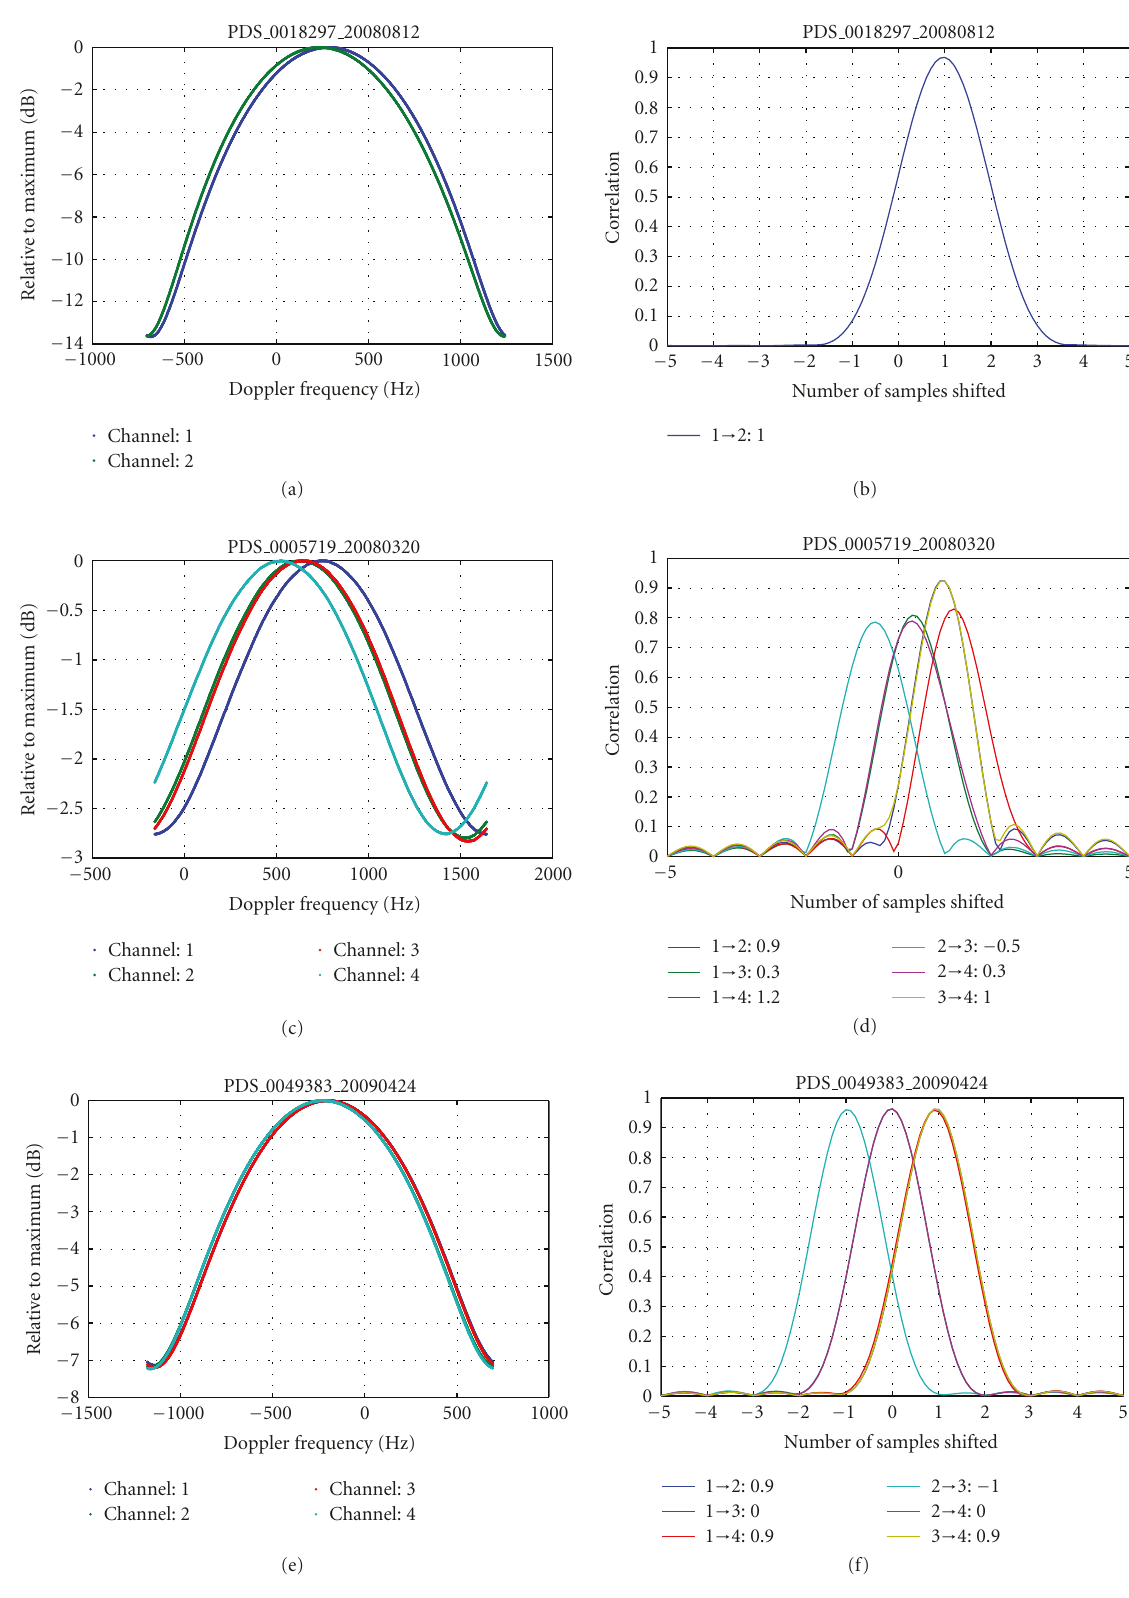
Figure 2: Estimated antenna patterns and channel correlations for three MODEX modes. (a) and (b) Standard dual-receive mode, (c) and (d) half-aperture toggle-transmit mode, and (e) and (f) 3/4-aperture toggle-transmit